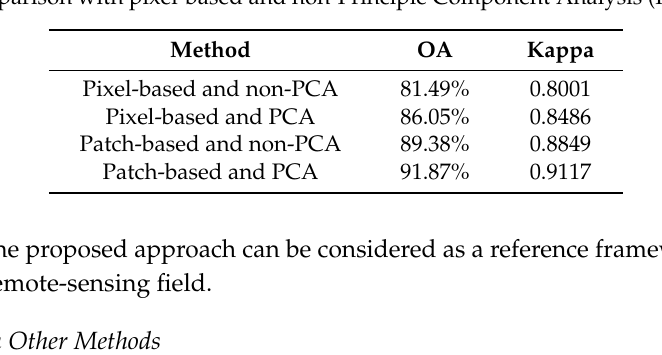
Table 6. Comparison with pixel-based and non-Principle Component Analysis (PCA) methods.